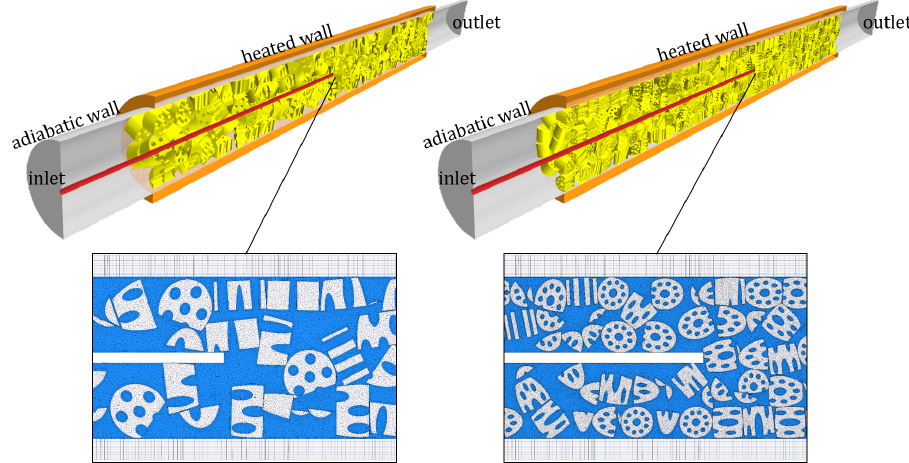
Figure 3. Visualization of the geometry and the mesh for a 6-hole tablet ( left ) and a 10-hole cylin- der ( right